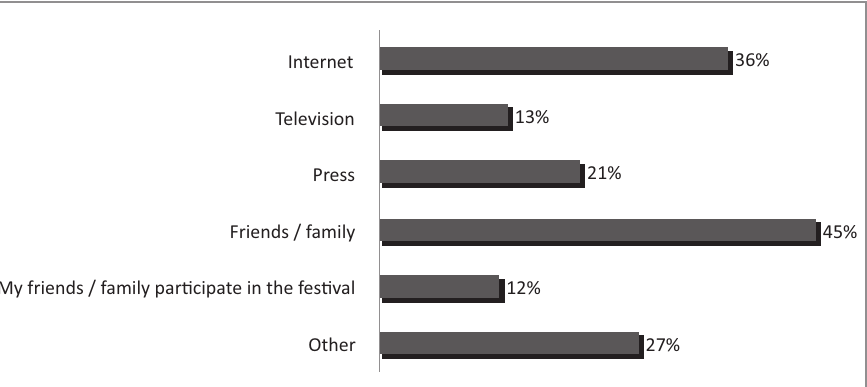
Fig. 16. Correlation between a channel visitors have found information about the festival and